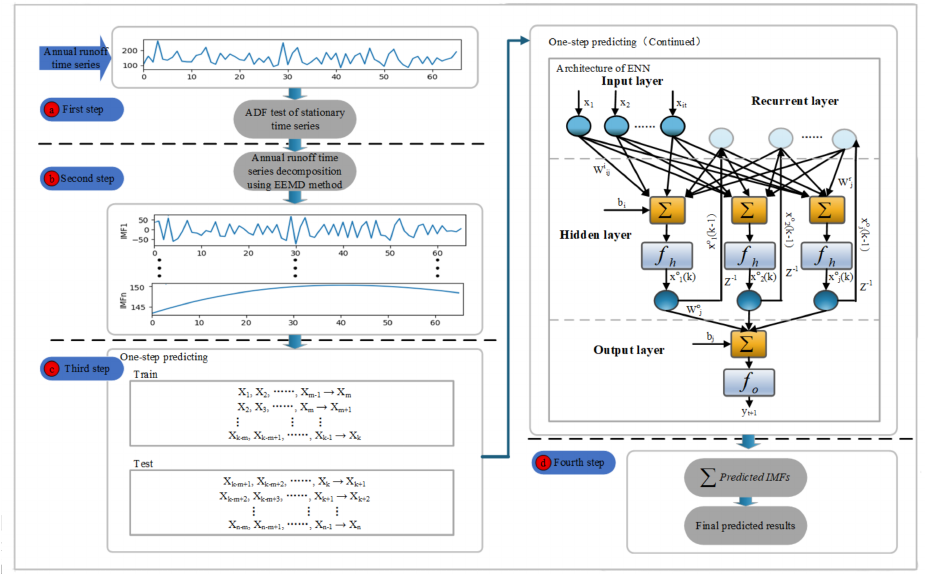
Figure 1. The flowchart of the proposed Ensemble EMD—Elman Neural Network (ENN) hybrid model for annual runoff time series